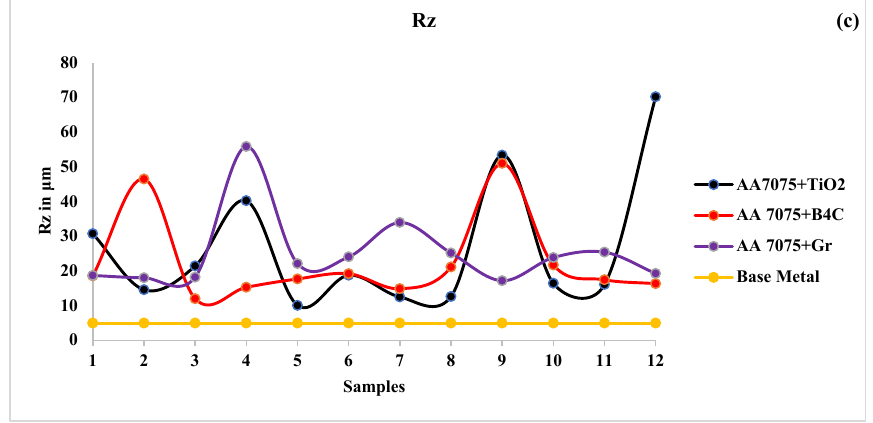
Figure 10. Surface roughness in terms of ( a ) Ra, ( b ) Rq and ( c ) Rz of FSPed AA 7075/TiO 2 / B 4 C/Gr produced by selected processing parameters as compared to FSPed AA7075.